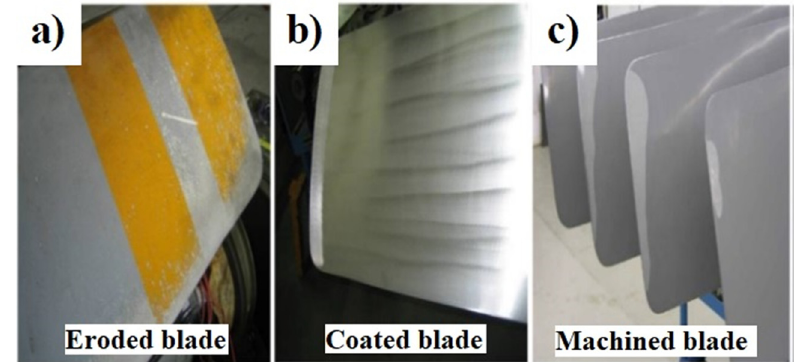
Figure 26: Restoration technique of Al alloy blades by CSA [ 81 ]